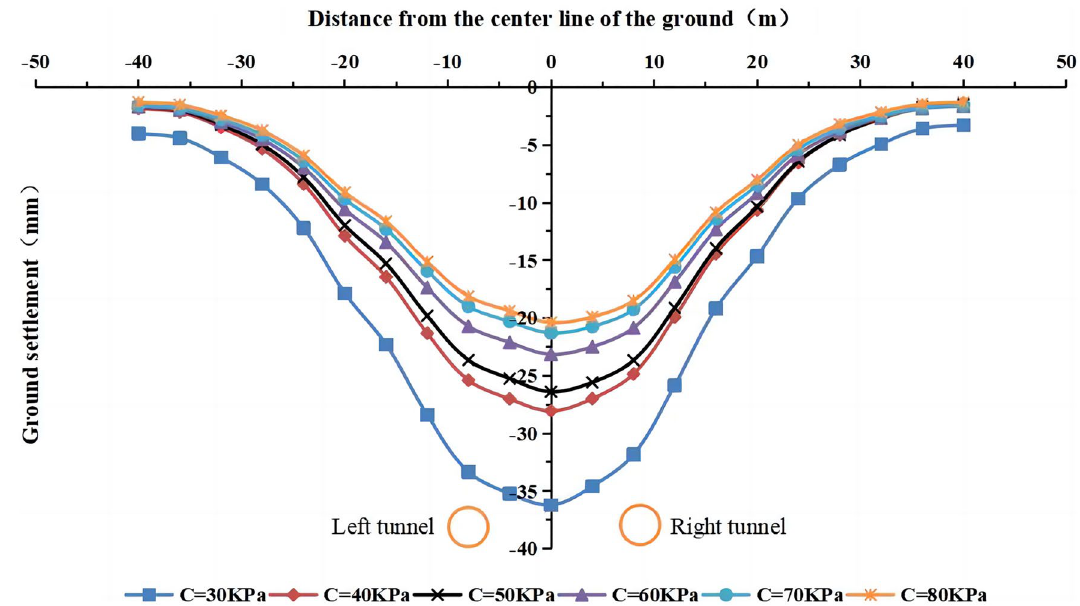
Figure 20. Surface settlement during double-line excavation for different cohesion values.